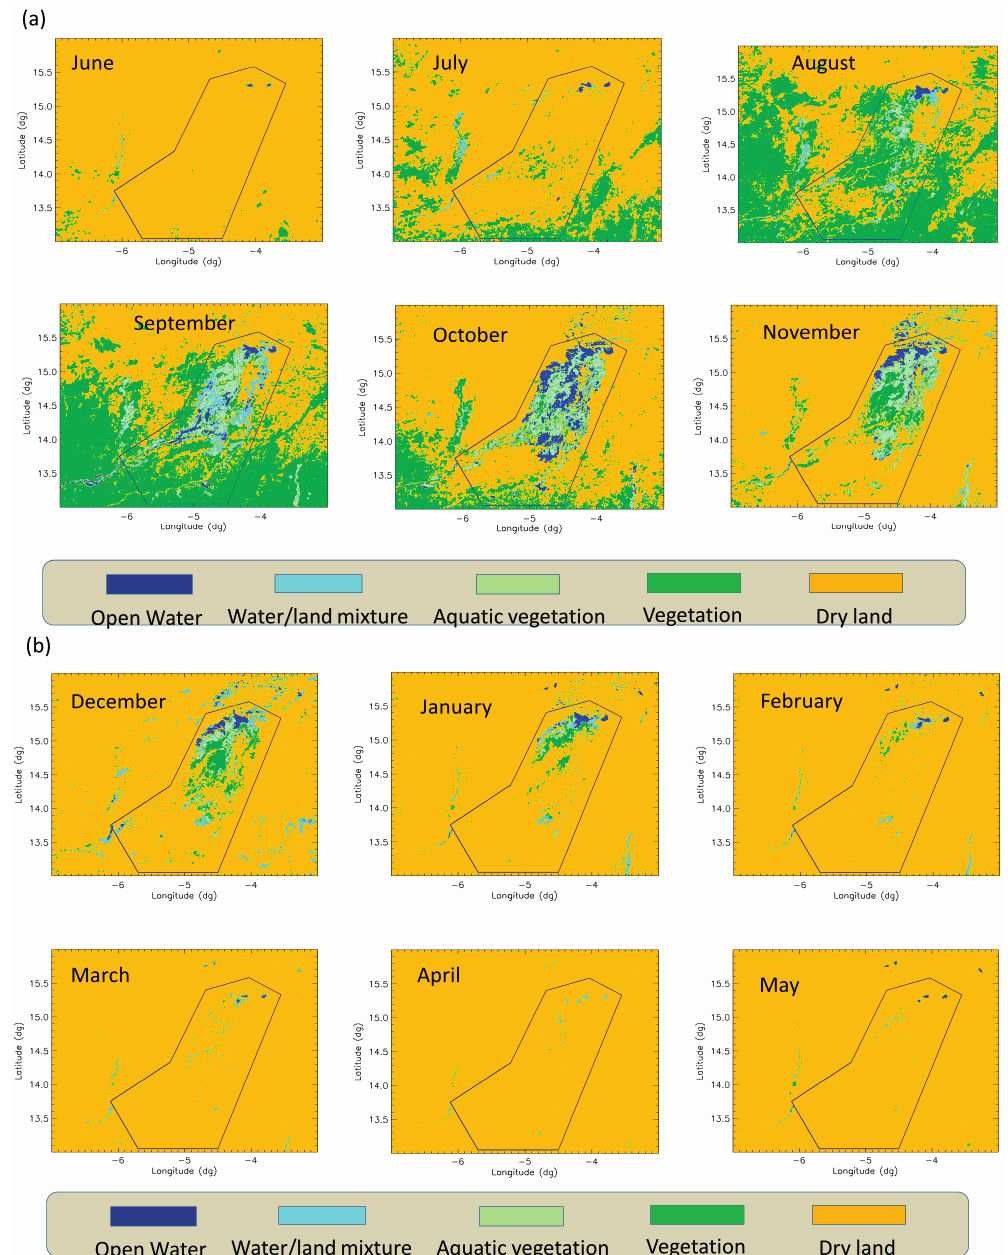
Figure 3. Moderate Resolution Imaging Spectroradiometer classification of the Inner Niger Delta (IND) with one image per month in 2003–2004 being selected for illustration of the inundation phenomenon over the Inner Niger Delta (IND) ( a ) from June to November 2003, ( b ) from December 2003 to May